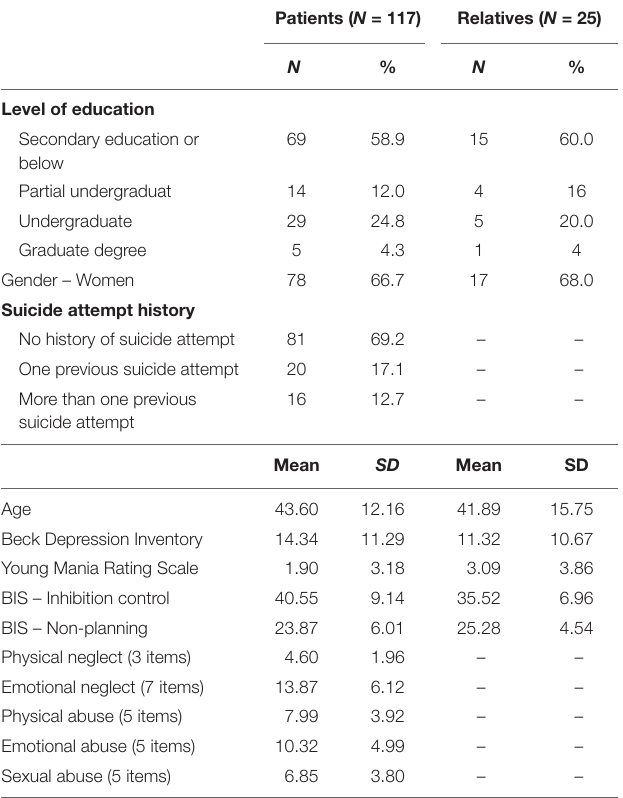
TABLE 1 | Sample characteristics.